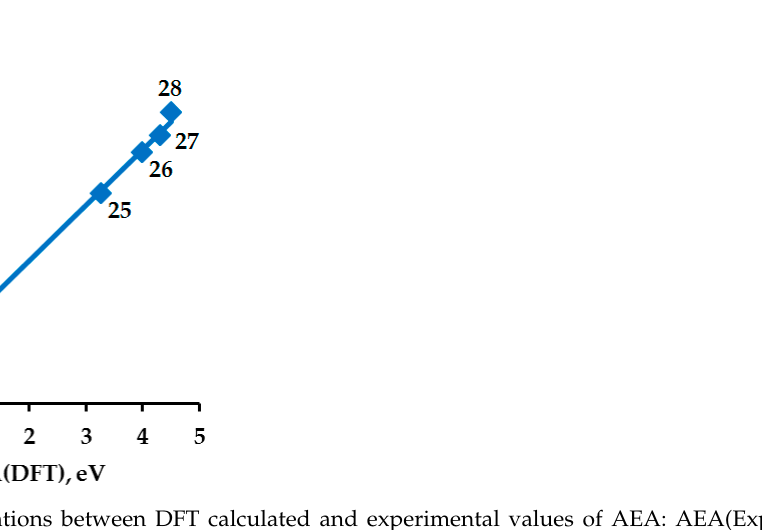
Table 1. Experimental and DFT calculated adiabatic electron affinities (AEA, eV) and DFT calculated